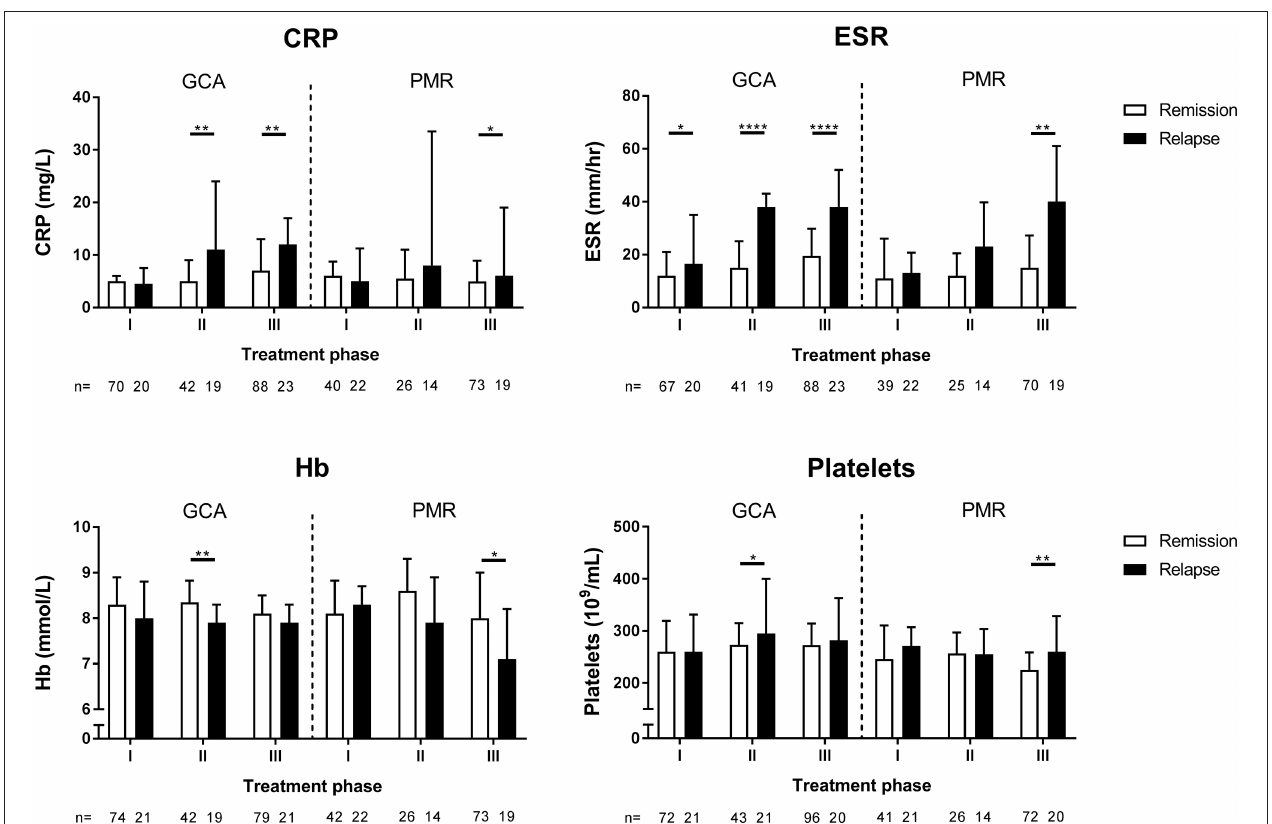
FIGURE 5 | Levels of inflammatory markers during treatment phase I, II, and III for GCA and PMR patients in remission and during relapse. The definition of remission and relapse was based solely on clinical signs and symptoms. Data is expressed as median plus interquartile range. The number of measurements is indicated by n . Statistical significance is expressed as follows: * p < 0.05, ** p < 0.01, **** p < 0.0001 (Mann Whitney U